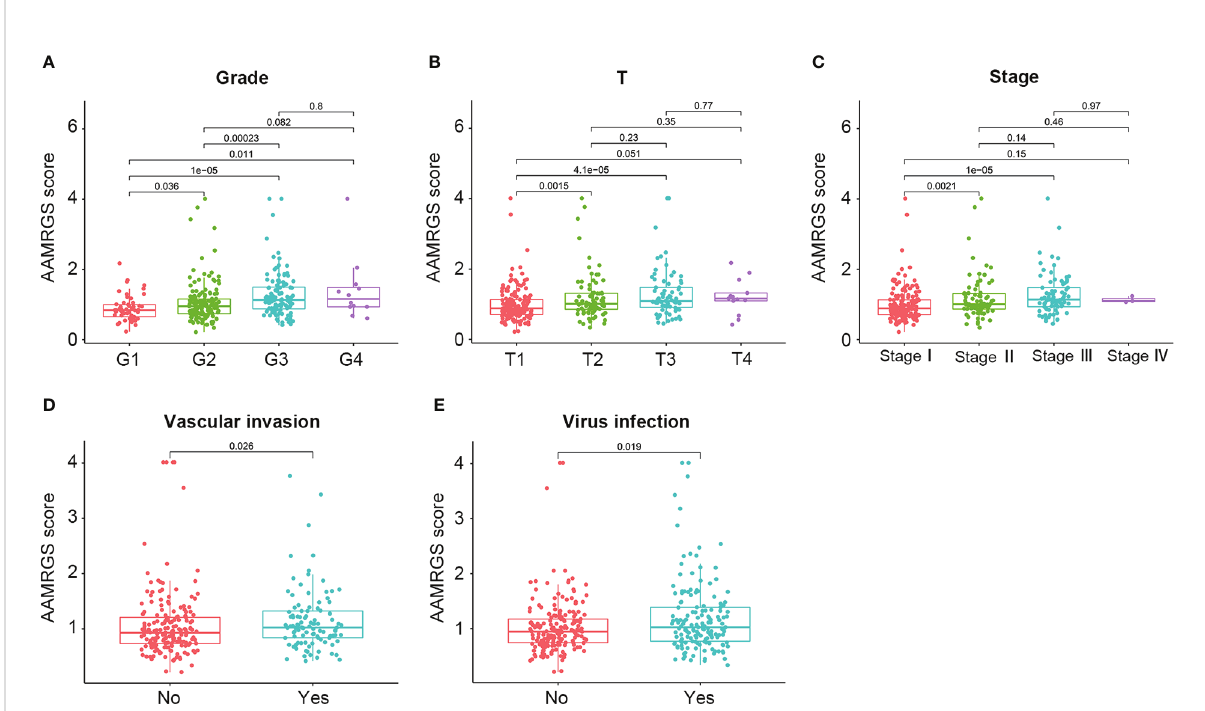
FIGURE 4 Correlation of the AAMRGS score with clinicopathological features in the TCGA-HCC cohort. (A) Pathological grade. (B) T staging. (C) Clinical staging. (D) Vascular invasion. (E) Virus